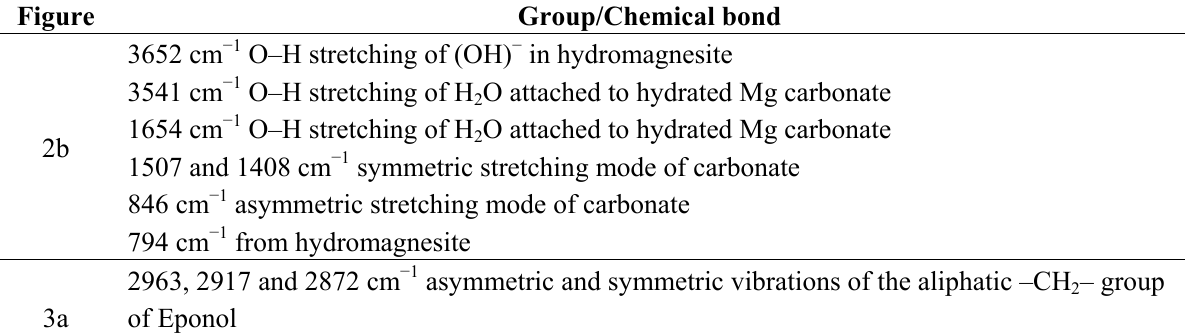
Table 1. Fourier transform infrared (FTIR) spectroscopy peak assignments. Figure